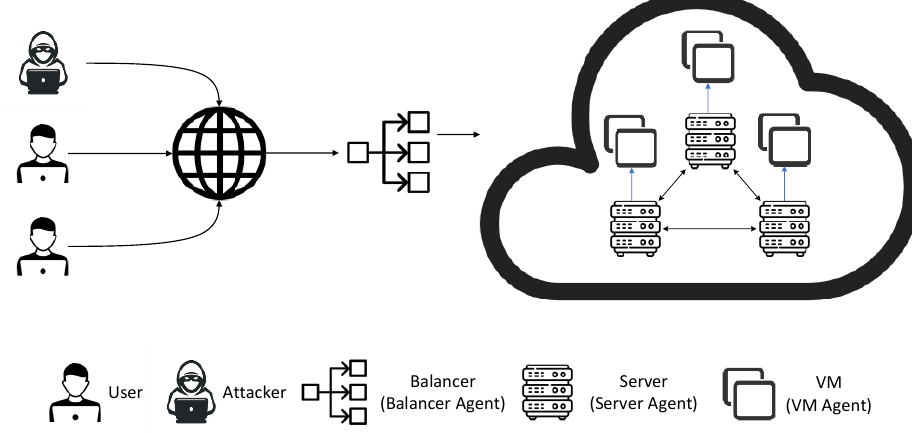
Figure 2. Agent-based VM application, allocation and migration architecture.